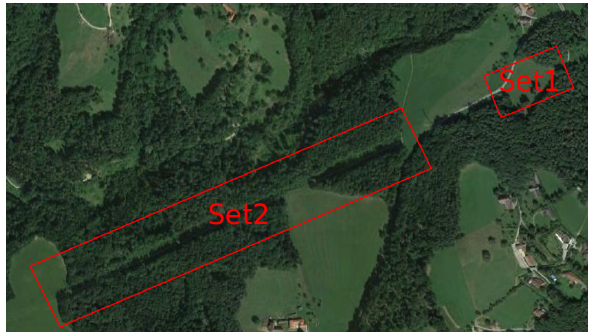
Figure 4. Overview of the test sets area: Image has been taken from Google Earth.